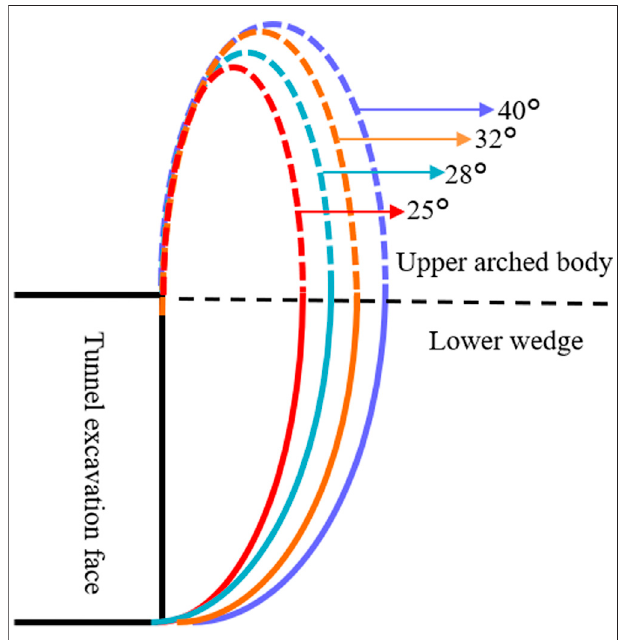
FIGURE 11 | Relationship between internal friction angle and tunnel instability